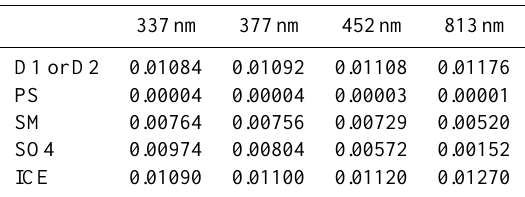
Table 4. Vertical extinction optical thickness in a 5km layer due to all simulated species, as described in Table 2.